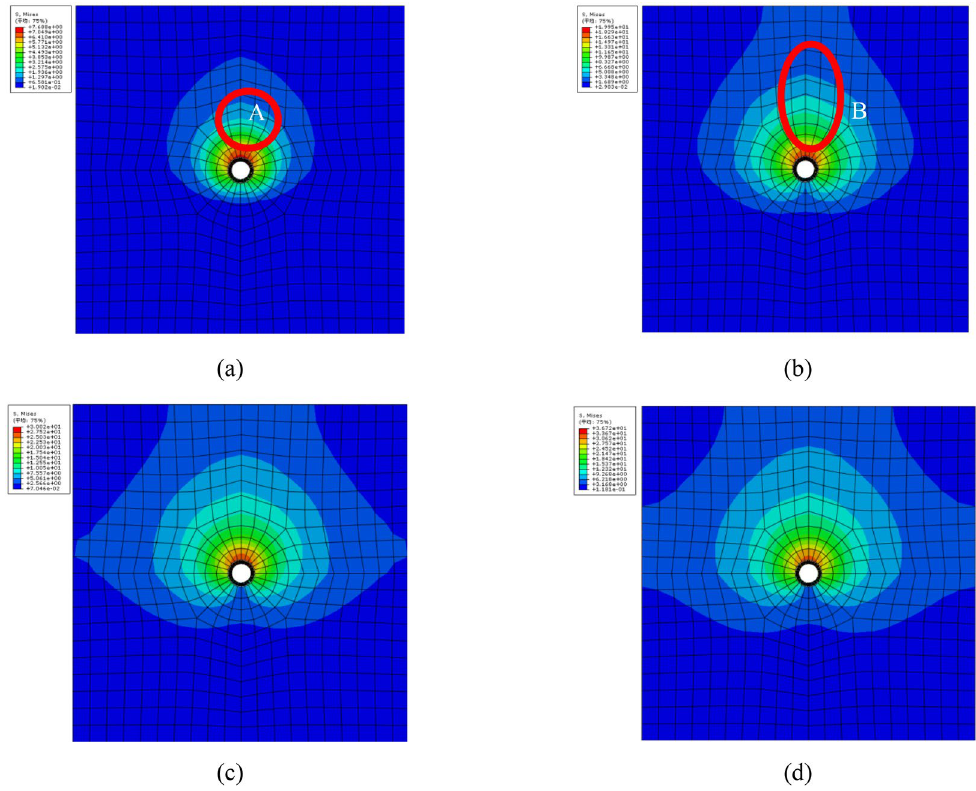
Figure 7. Staged profile of tensile stress in numerical simulation under non-uniform corrosion, ( a ) a stage, ( b ) b stage, ( c ) c stage, ( d ) d stage.